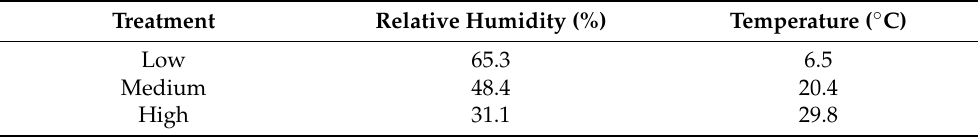
Table 2. Average environmental conditions per